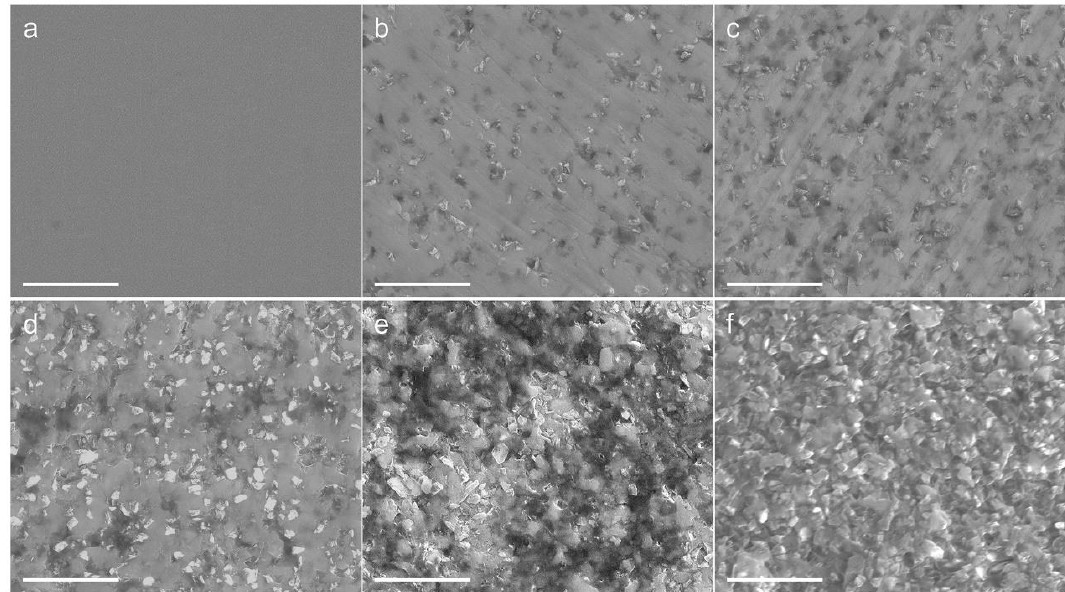
Figure 3. SEM micrographs showing the microstructure of the TiO 2 -diamond composites. ( a ) T-0%D, ( b ) T-10%D, ( c ) T-20%D, ( d ) T-30%D, ( e ) T-40%D, ( f ) T-50%D. The scale bars are 5 μm.